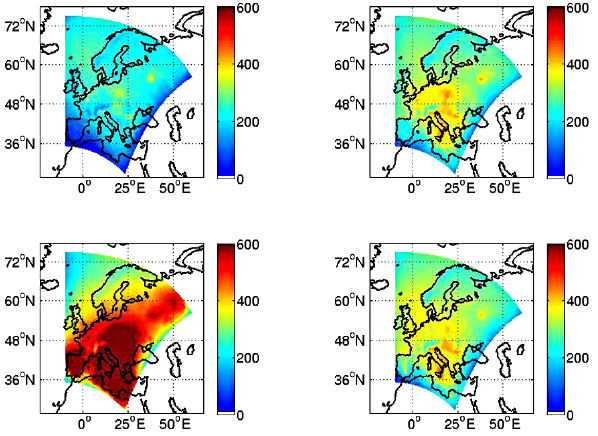
Figure 4. Seasonal mean in-cloud averaged cloud droplet number concentrations (cm − 3